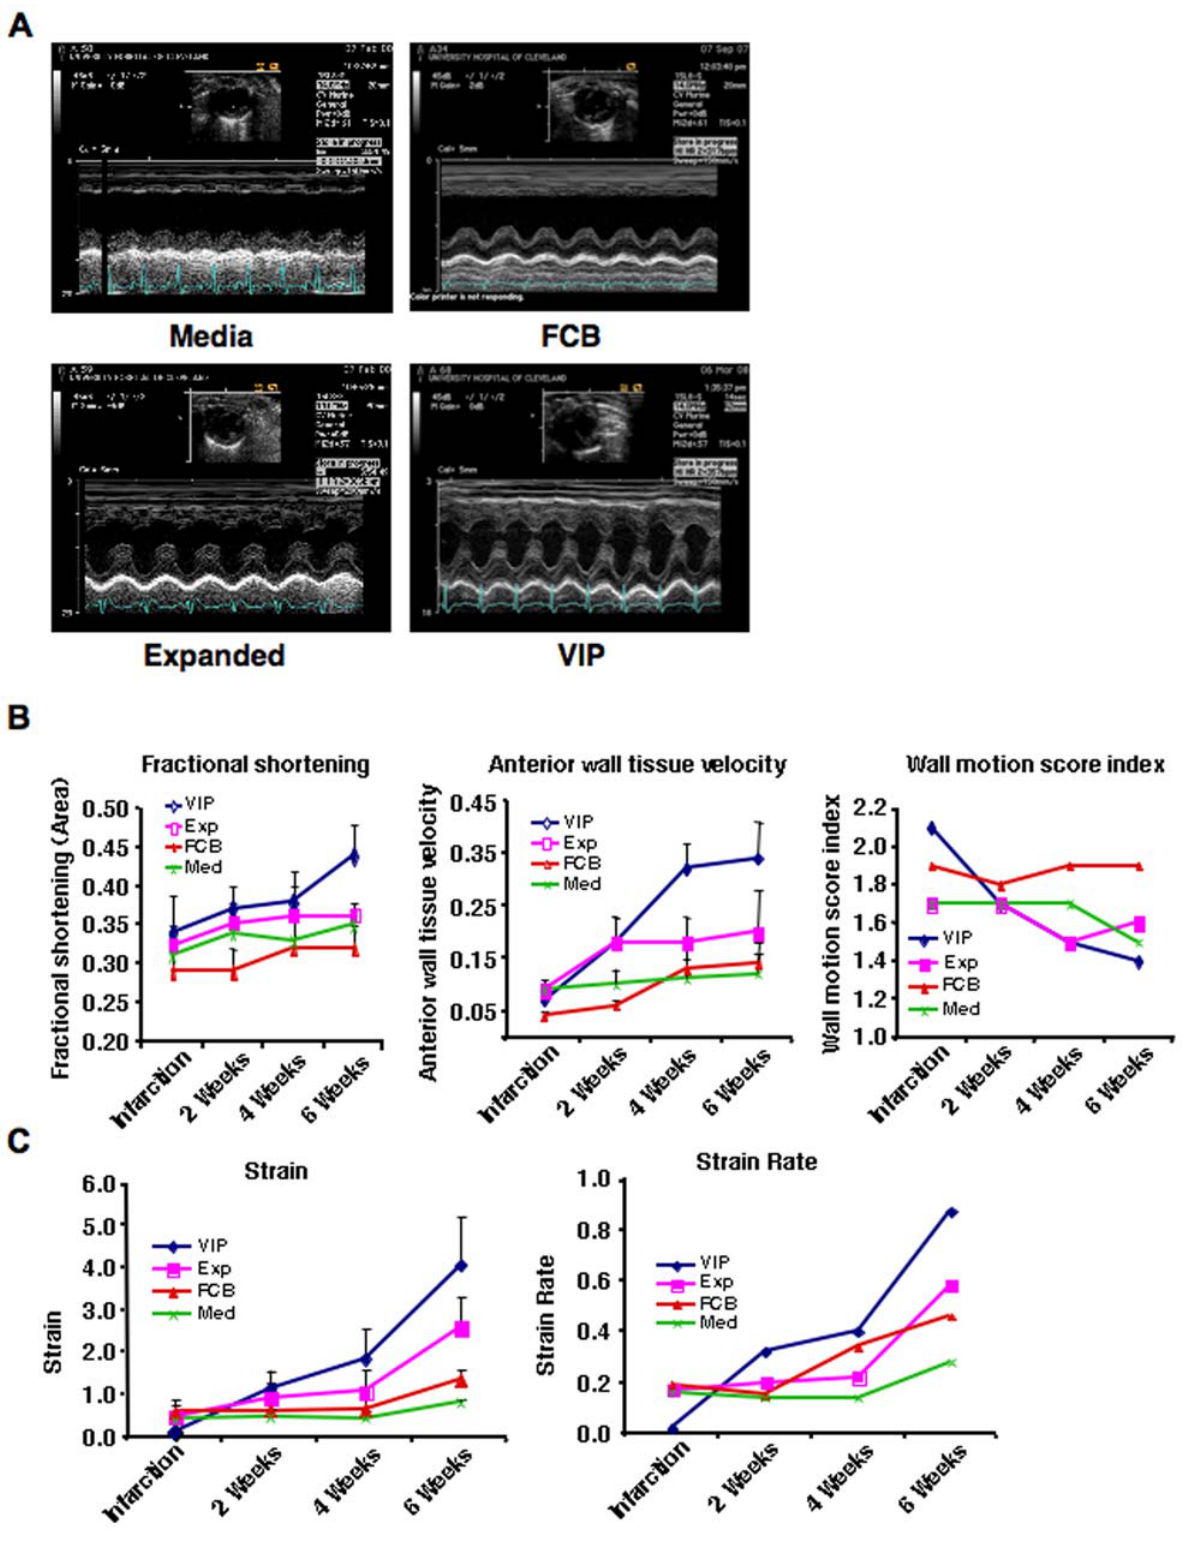
Figure 2. Evaluation of cardiac function by echocardiography. (A) Representative M-mode echocardiographic images after six weeks of therapy demonstrating improved anterior wall motion in the VIP . Exp . FCB . Med groups. Inset shows the short axis two-dimensional image of the LV. (B) Echocardiographic parameters of cardiac function using fractional shortening (FSa), anterior wall tissue velocity (TVa) and wall motion score index (WMSI) plotted as a function of time within each group demonstrating significant improvement in function in the VIP group compared to controls. (C) Strain and strain rates presented as a function of time within each group with significant improvement in the VIP group.